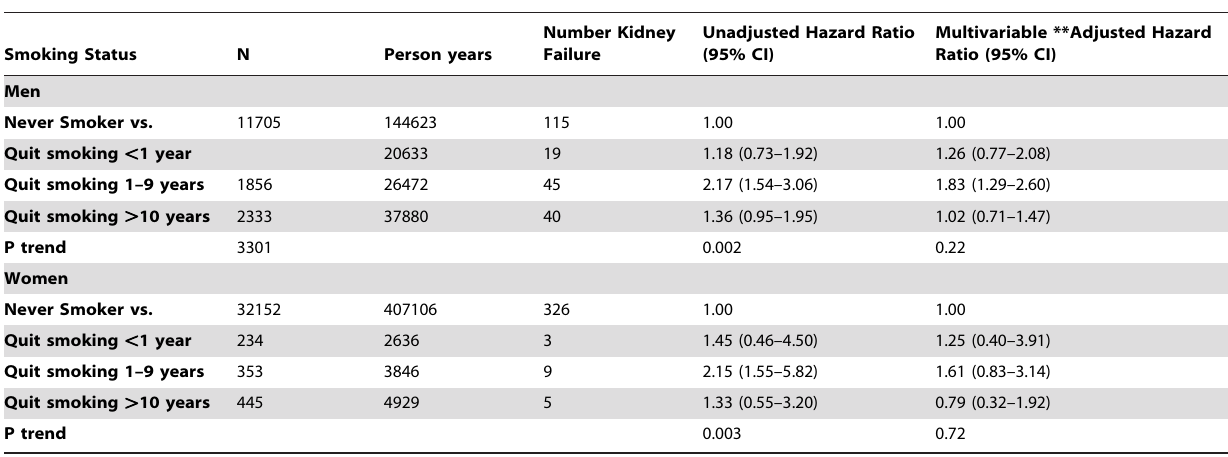
Table 5. Association of smoking cessation with Kidney Failure in Singapore Chinese Health